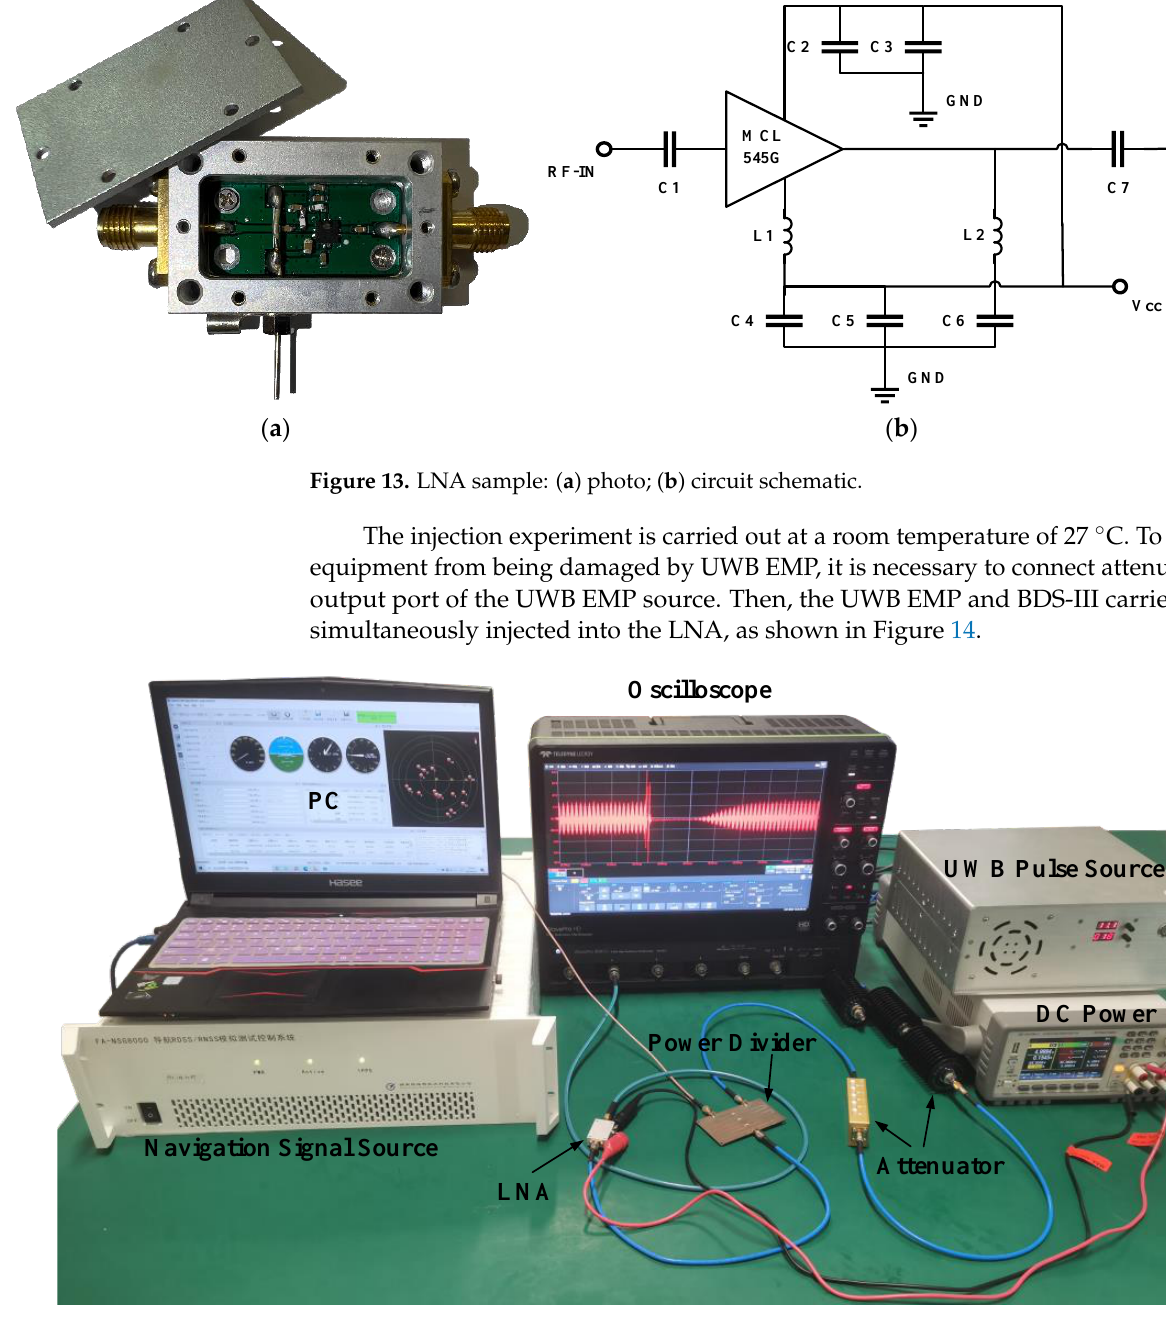
Figure 14. Experiment environment for the LNA.